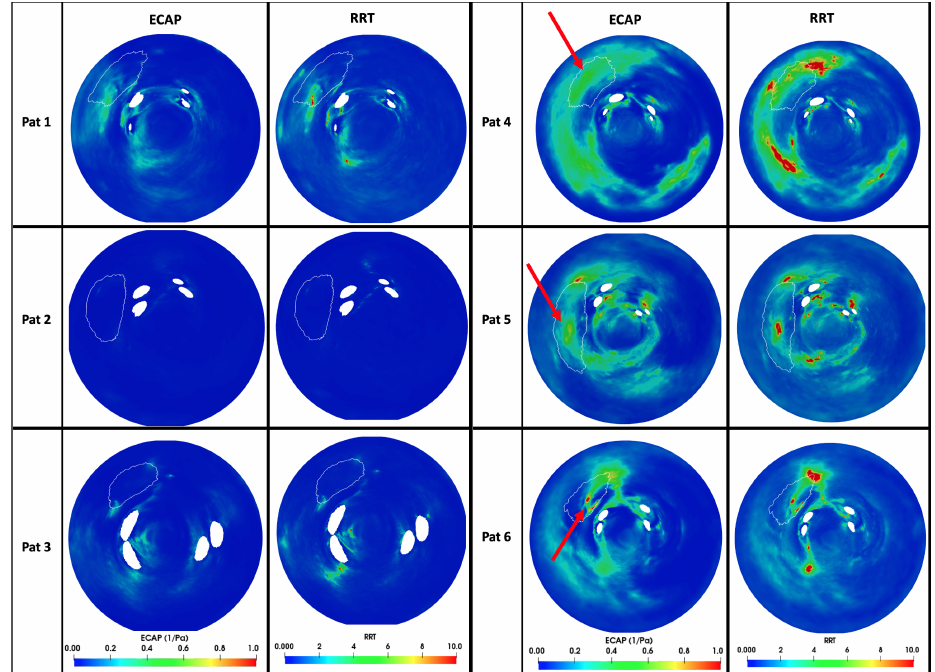
Figure 5. In silico haemodynamic indices for the prediction of device-related thrombosis (DRT) after left atrial appendage occlusion in the six analysed cases: Pat 1–3 were controls and Pat 4–6 had DRT. Higher values (red colour) indicate a higher risk of thrombosis. The white line in the 2D maps signals the position of the implanted device. ECAP: endothelial cell activation potential; RRT: relative residence times. The red arrows indicate the positions where the thrombus were found in the post-procedural computed tomography images (see Figure 6).